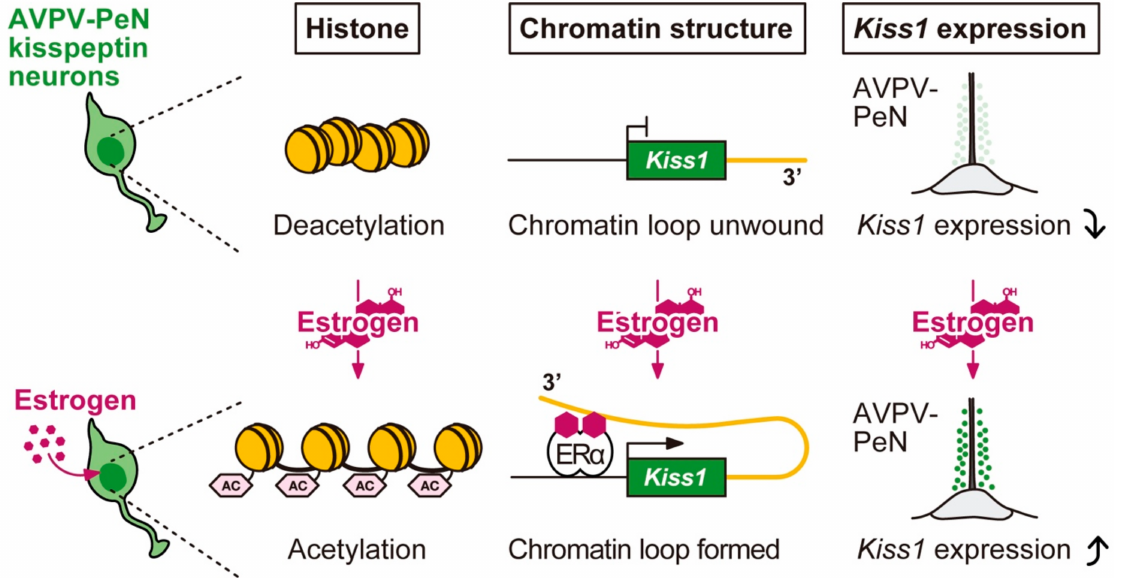
Figure 3. Putative molecular mechanism of the estrogen positive feedback action on Kiss1 expression in the anteroventral- periventricular nucleus-periventricular nucleus continuum (AVPV-PeN). Preovulatory levels of circulating estrogen seem to act on AVPV-PeN kisspeptin neurons, in which estrogen-bound estrogen receptor α (ER α ) may increase Kiss1 expression via histone acetylation of Kiss1 promotor region and chromatin loop formation between the Kiss1 promoter and the 3 (cid:48) - intergenic regions of Kiss1 locus. In the absence of estrogen, AVPV-PeN Kiss1 expression may be down-regulated by histone deacetylation of the Kiss1 promotor region and unwinding chromatin loops between the Kiss1 promoter and the 3 (cid:48) -intergenic regions of the Kiss1